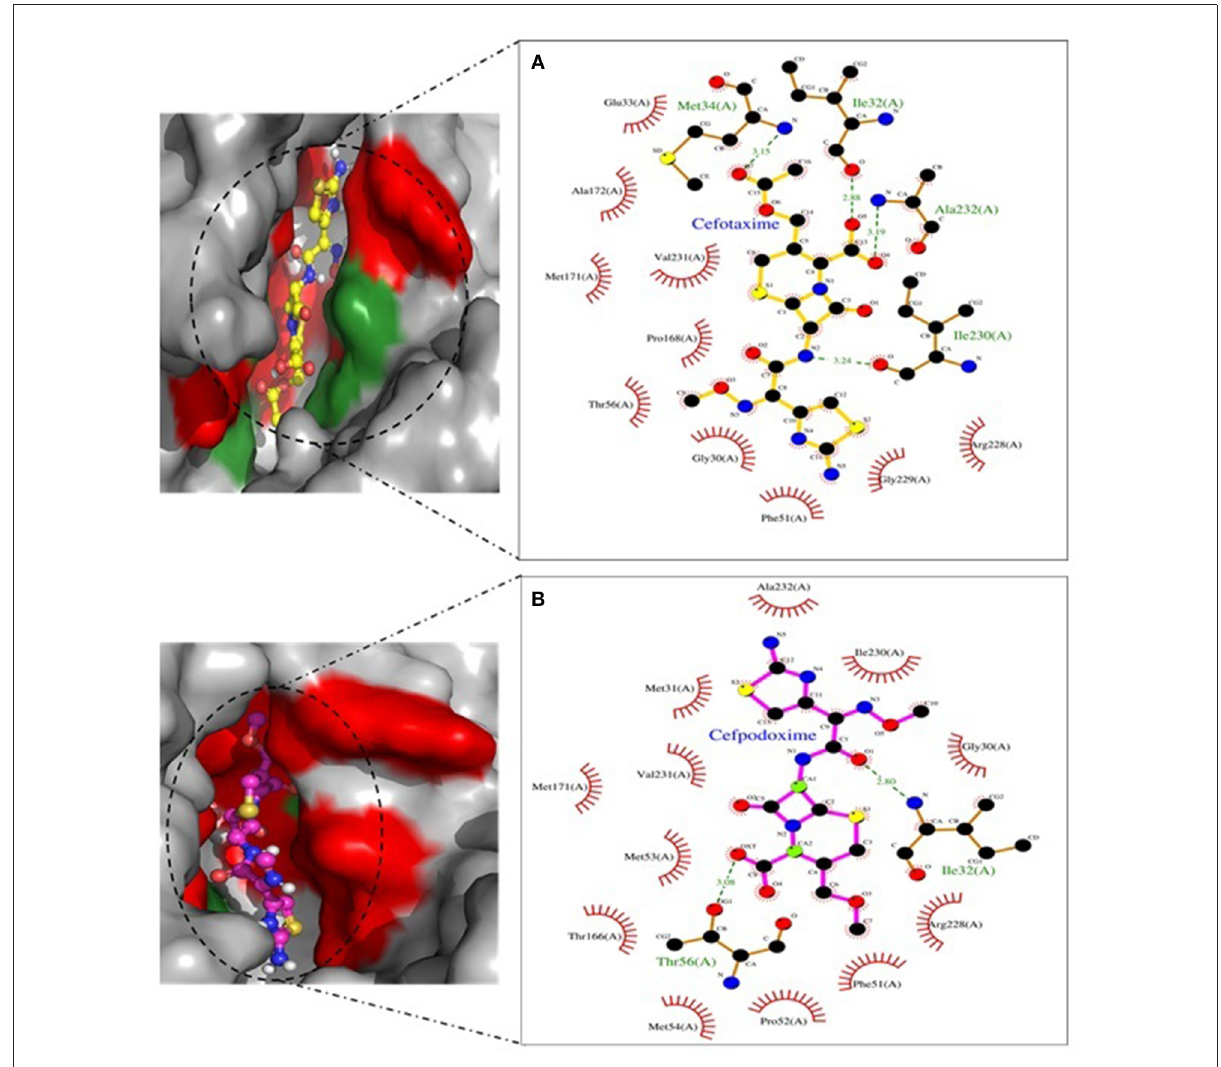
FIGURE8 SHV-27 involved in interactions. (A) A binding map for cefotaxime + SHV-27. (B) A binding map for cefpodoxime +